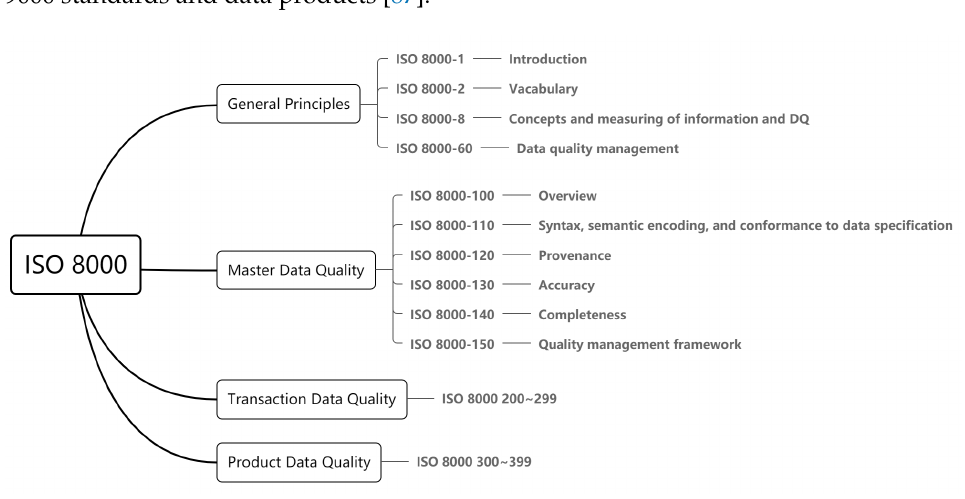
Figure 3. Components of the ISO